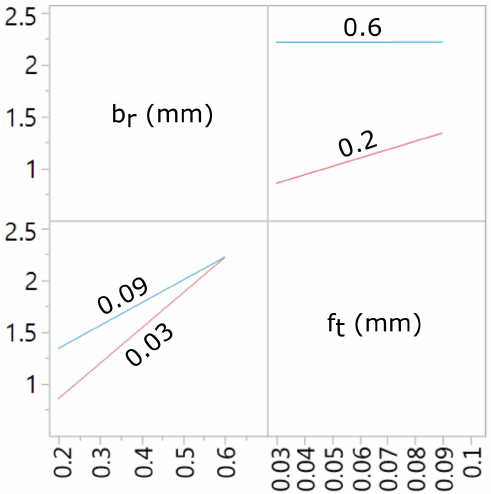
Figure 14. Interaction plot for a model with the (cid:98) Sz output